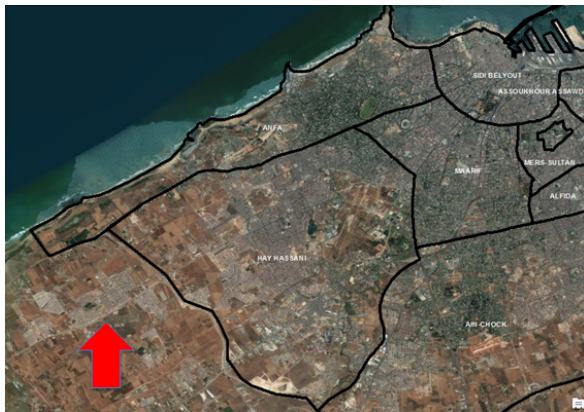
Figure 1: Peripheral commune concerned by the household